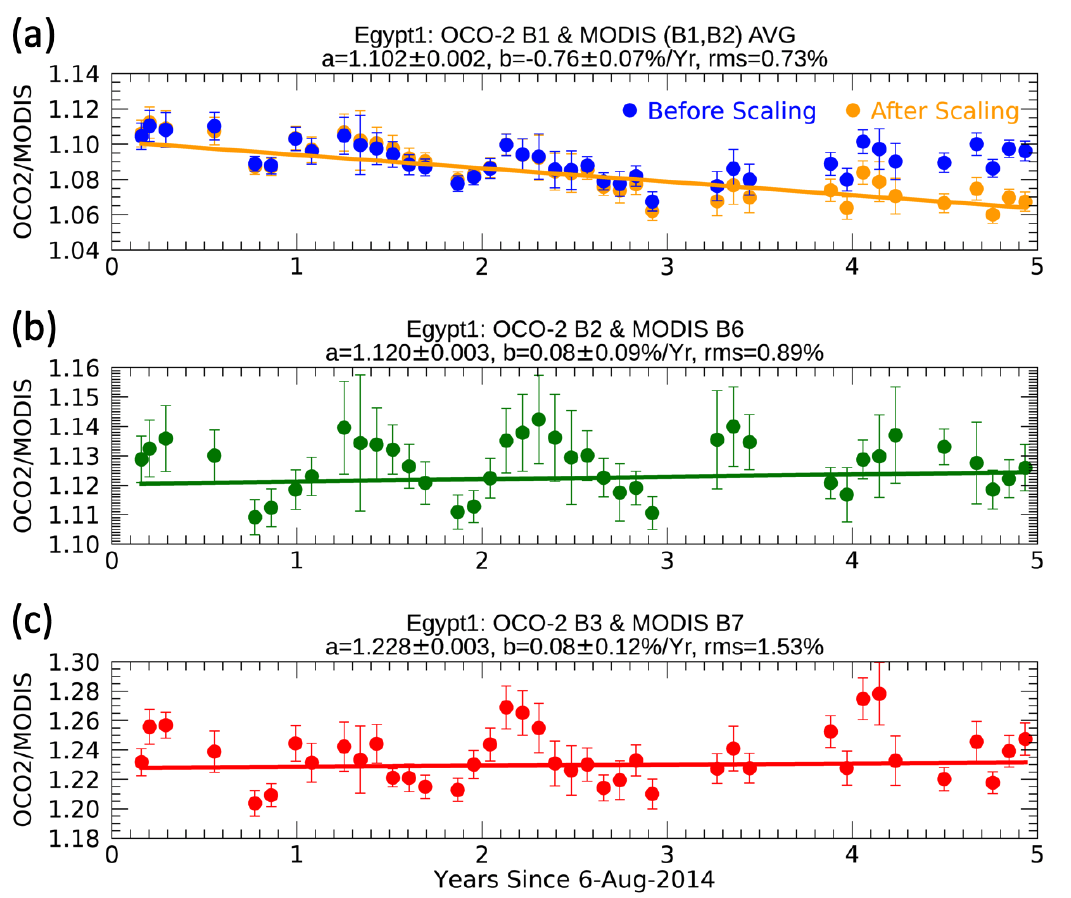
Figure 5. Five-year time seriesof the OCO-2/MODIS radiance ratio for all three OCO-2 bands over Egypt1: Panel ( a ) for OCO-2 Band 1; Panel ( b ) for OCO-2 Band 2; Panel ( c ) for OCO-2 Band 3. In Panel ( a ), Orange data points denote the result corrected for an error in modeling the aging of the solar